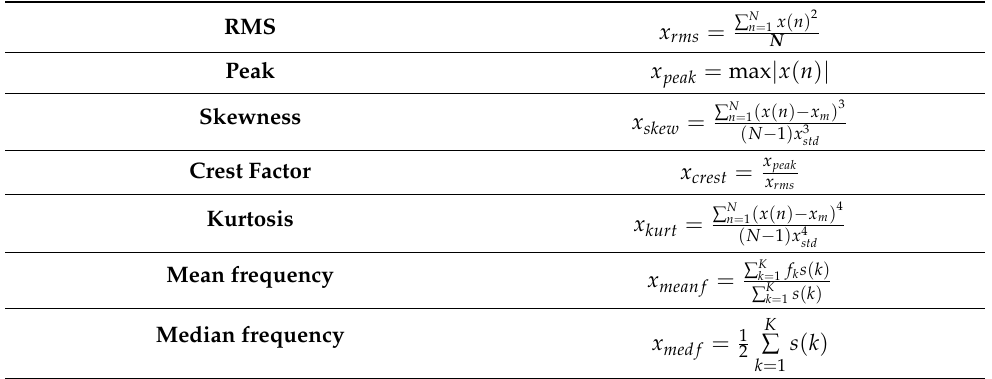
Table 3. Equations for the extracted features